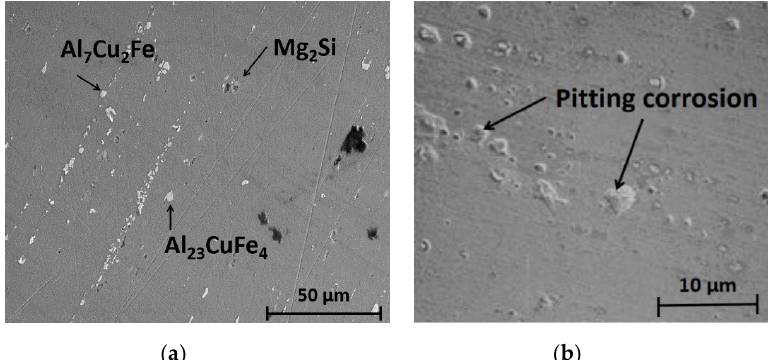
Figure 6. ( a ) SEM image of the microstructural composition of the UNS A97075 alloy tested (before machining and corrosion processes); ( b ) SEM image of the pitting corrosion effect on the machined surface.